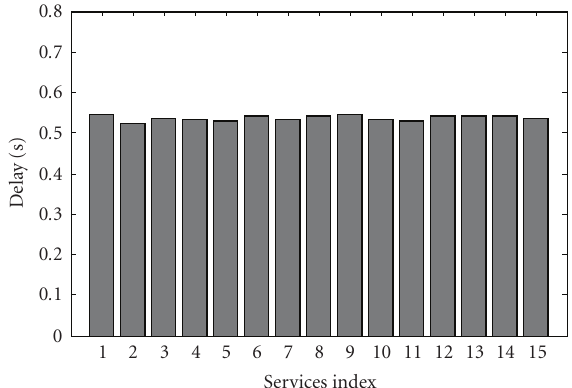
Figure 11: Bu ff ering delay for 15 multiplexed services in DetMux, bit streams have di ff erent bu ff ering